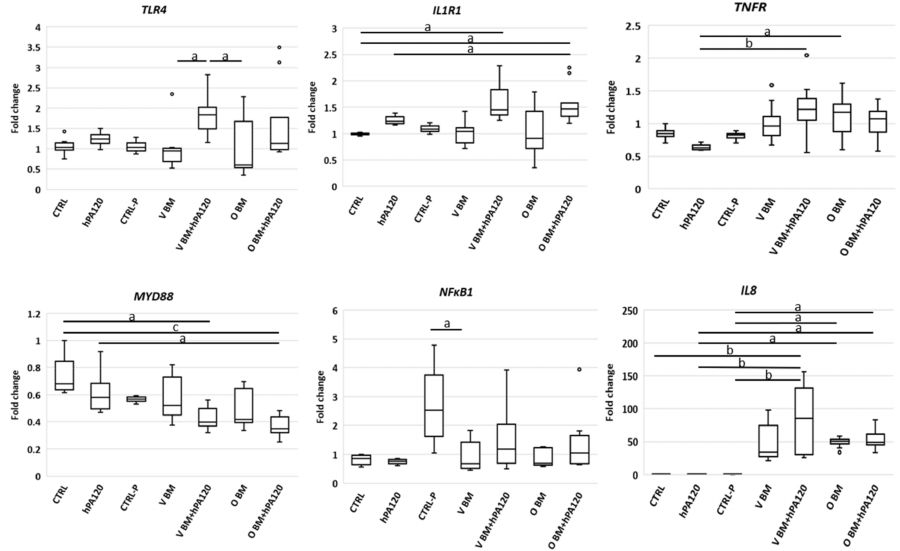
Figure 6. Gene expression in HCT116 cells treated with fecal bacteria derived from vegan (V) or omnivorous (O) volunteers. Fecal bacteria were grown in Wilkins–Chalgren medium supplemented with 0.5% of mucin and 1 mM of phytic acid for 42 h at 37 ◦ C in an anaerobic atmosphere. The treatment was performed with bacteria alone (BM) or with bacteria and the hydrolysate of phytic acid (BM + hPA120), for 2 h at 37 ◦ C. The controls were: non-treated colonocytes (CTRL), colonocytes treated with hPA120 and colonocytes treated with non-inoculated microbiological medium treated as bacterial cultures (CTRL-P). Whiskers—non-outliers, box—25–75% non-outliers; horizontal line in the box—median; circles—outliers. Kruskal–Wallis was applied to calculate significant differences between the treatments, which are marked with: a—values different at p < 0.05; b—values different at p < 0.01; c—values different at p <